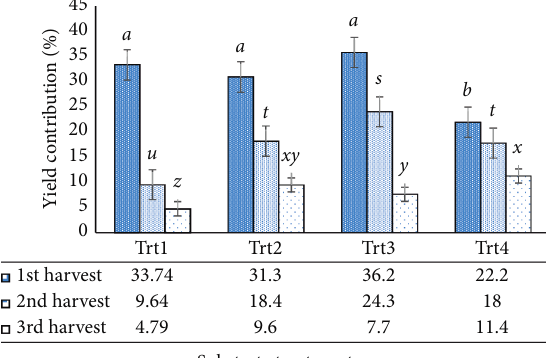
Figure 4: Contribution to biological yield of the first three harvest flushes of the mushroom as affected by substrate treatment. Columns with different letters are significantly different at p < 0 . 05. Trt 1 � baobab fruit shells, Trt 2 � wheat straw, Trt 3 � sawdust, and Trt 4 � maize cobs.